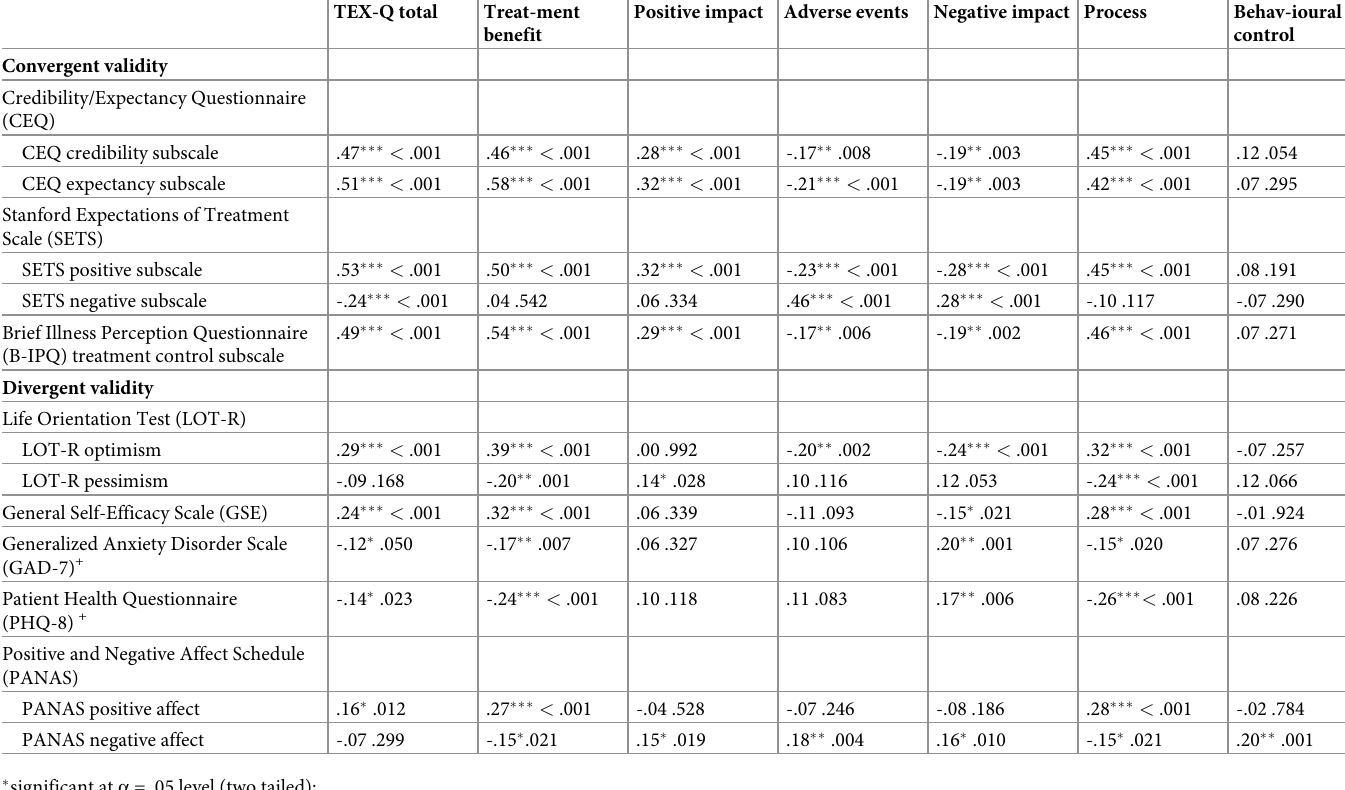
Table 3. Convergent and divergent validity of the Treatment Expectation Questionnaire (TEX-Q) in the validation sample (n = 251): Pearson correlation coeffi- cients, significance level (two